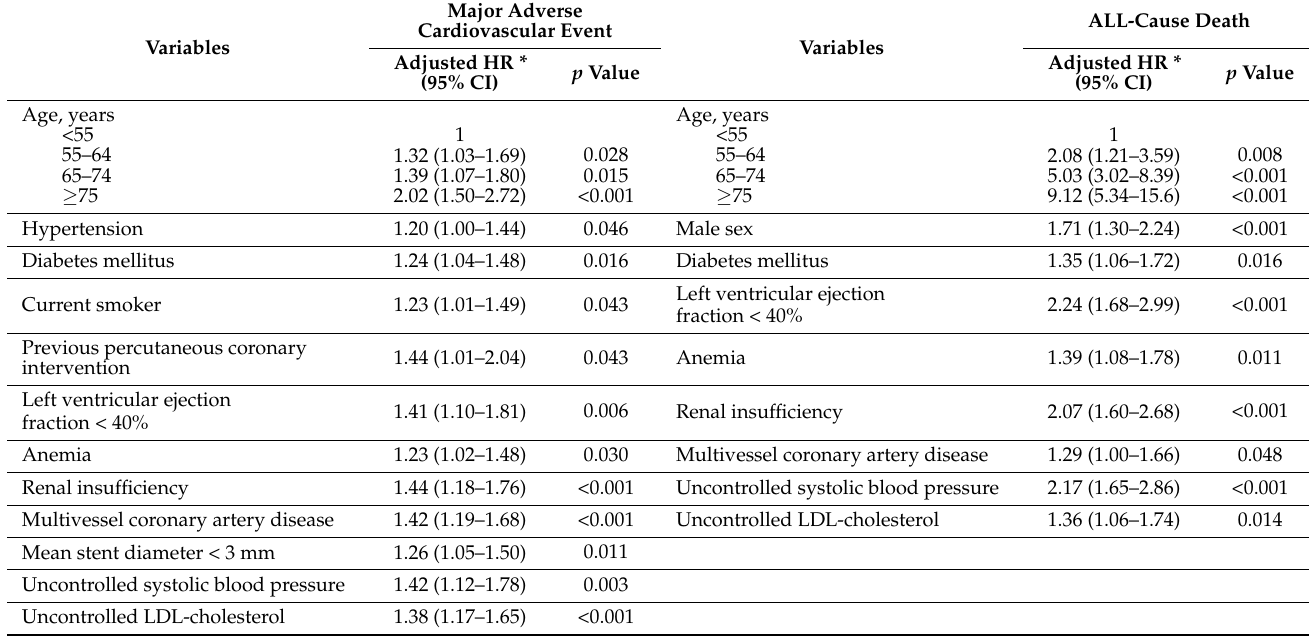
Table 3. Multivariable Cox regression analysis of factors associated with major adverse cardiovascular events and all-cause death more than 1 year after percutaneous coronary